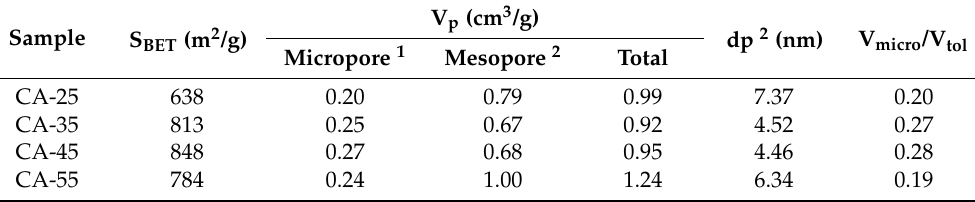
Table 1. Textural structure parameters of CA-X